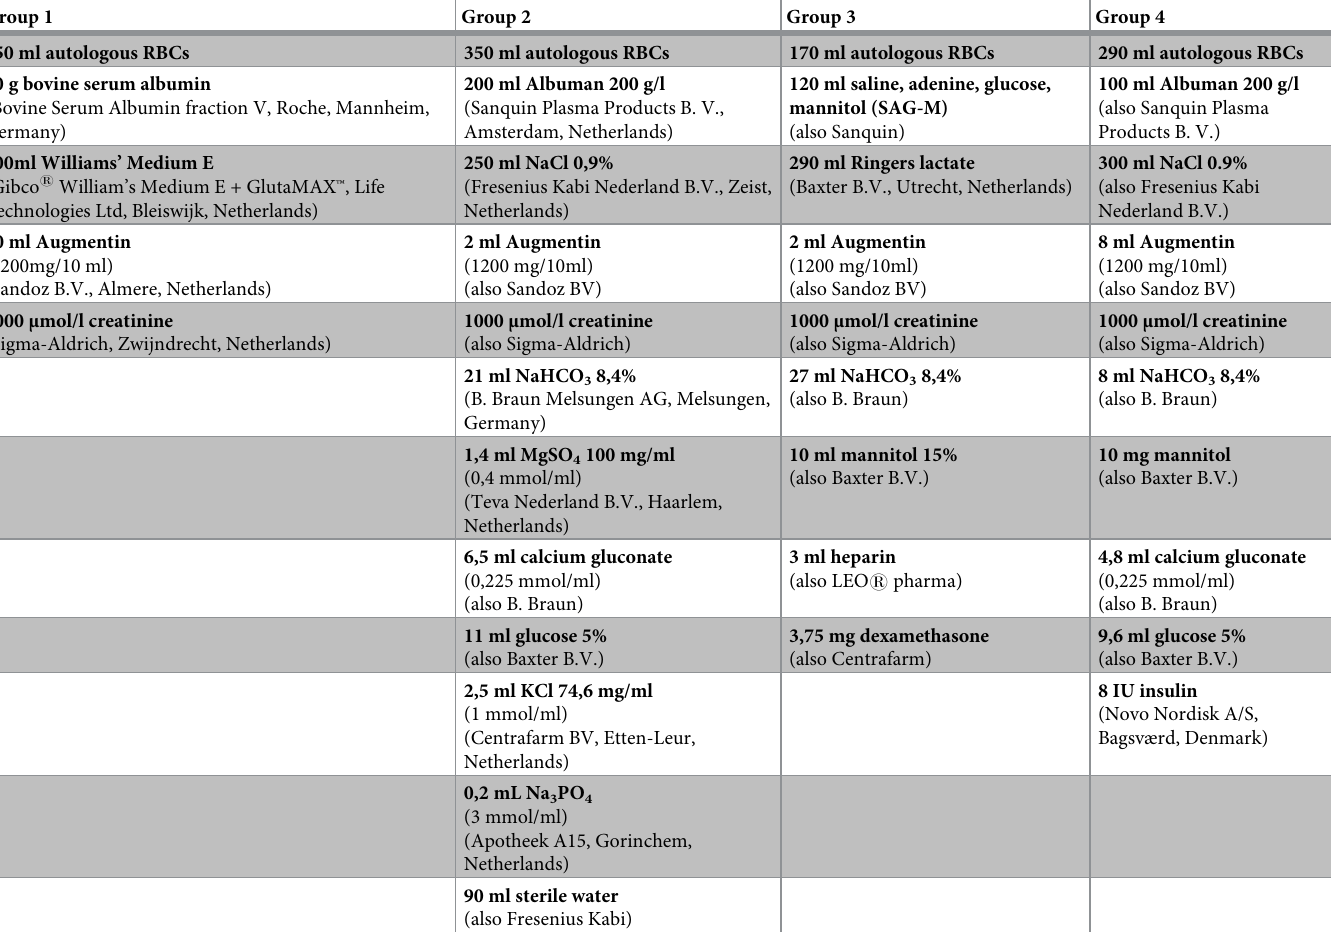
Table 1. Composition of the four perfusion